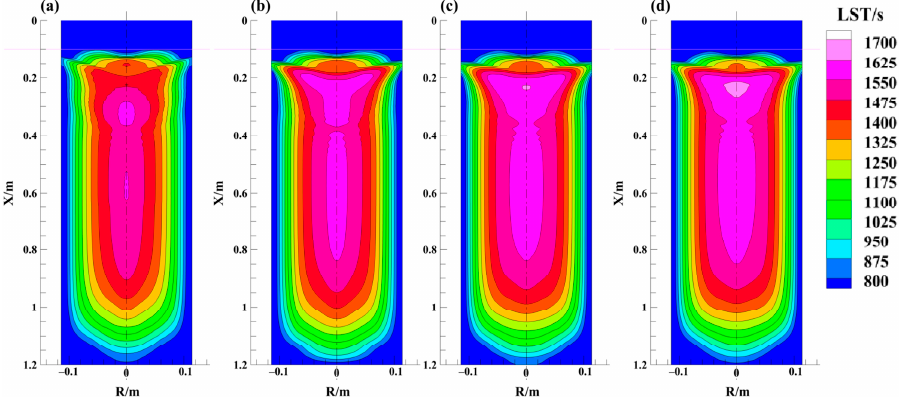
Figure A3. LST distribution with varying filling ratio: ( a ) 0.16, ( b ) 0.23, ( c ) 0.33 and ( d ) 0.43.